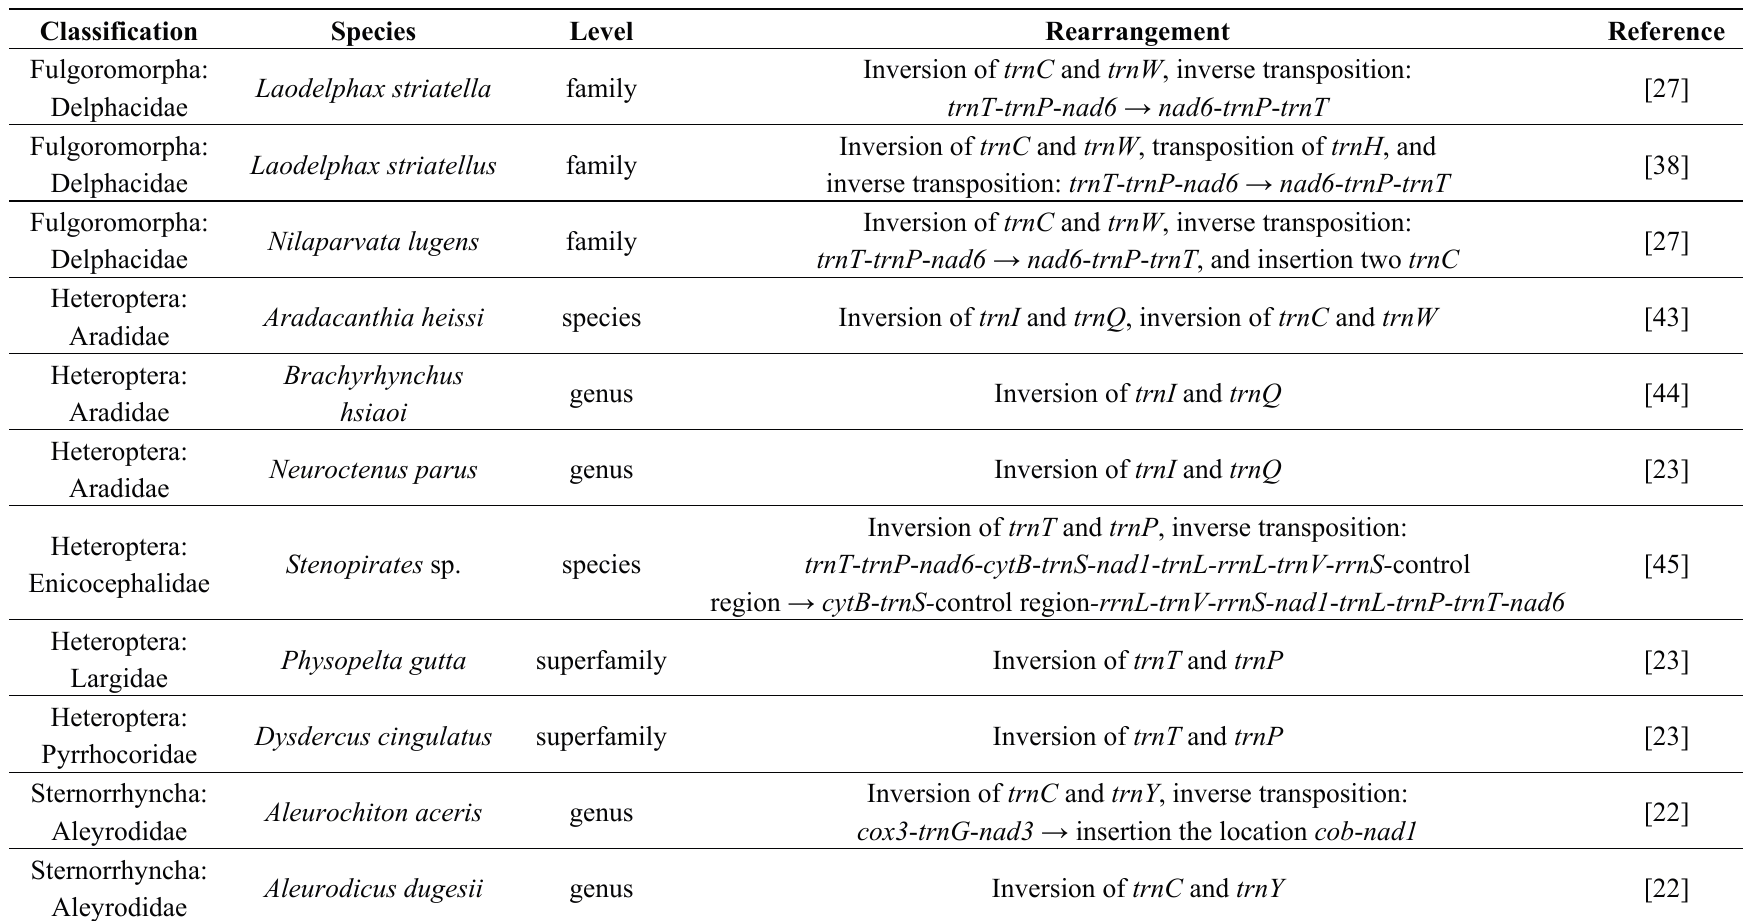
Table 3. Mitogenome rearrangements found in